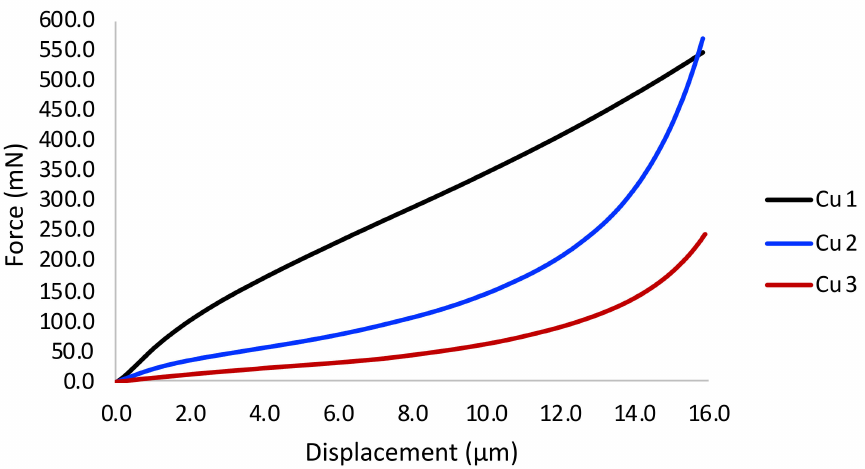
Figure 2. Presentation of the average force vs. displacement curves obtained from microparticulate compression testing of the three copper powders. Table 3. Ultimate tensile strength, average force required to reach a displacement equal to half the particle diameter, average displacement, and average powder particle diameter tested, for Cu